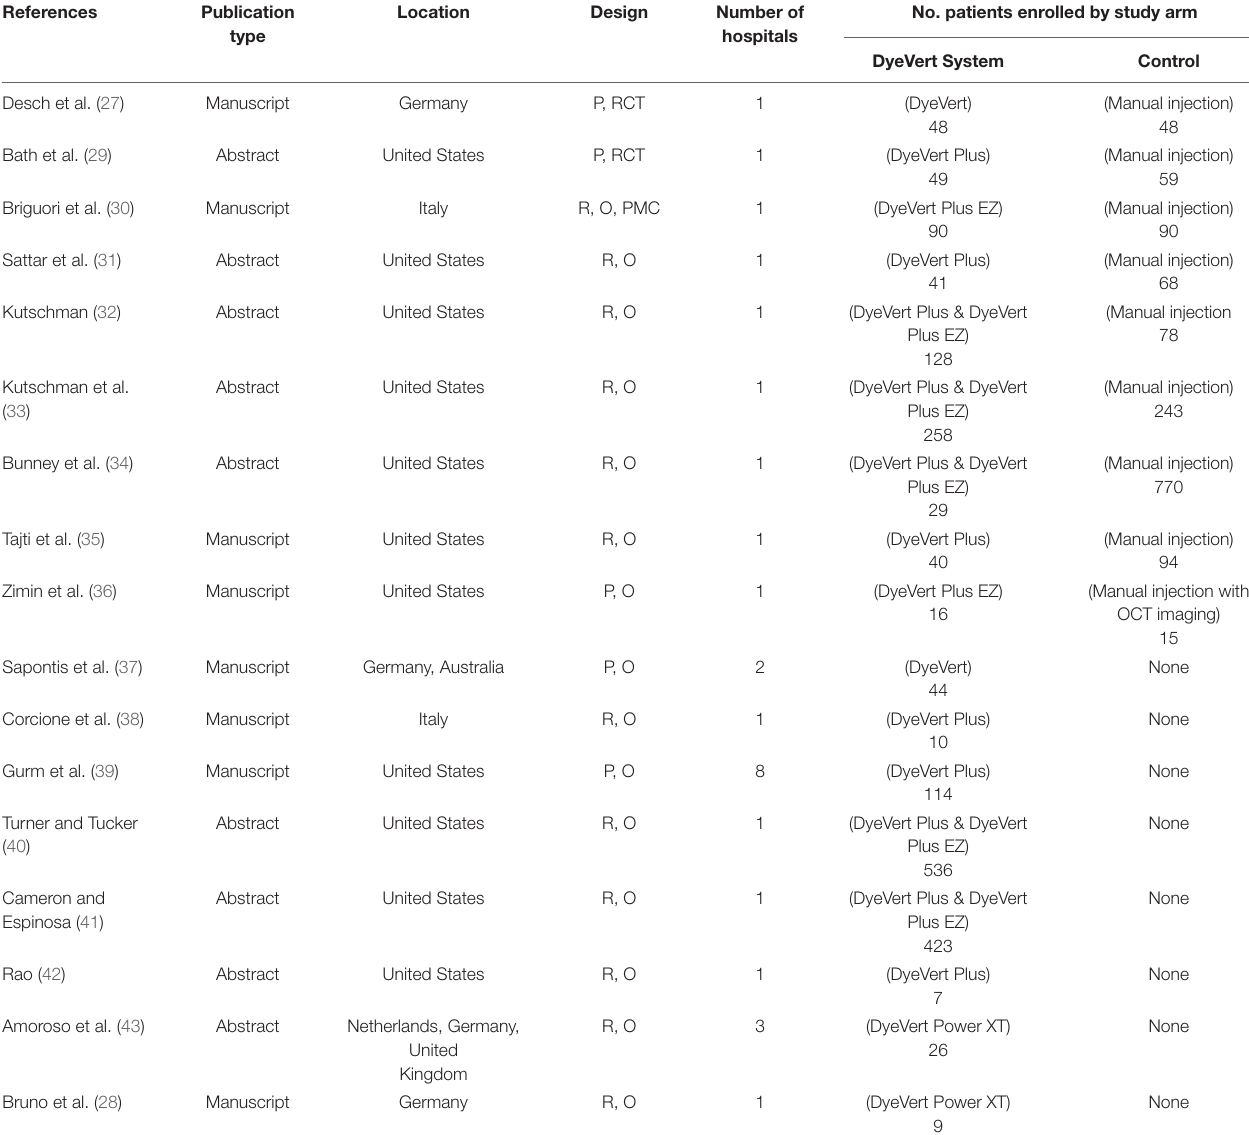
TABLE 1 | Summary of studies included in systematic review and